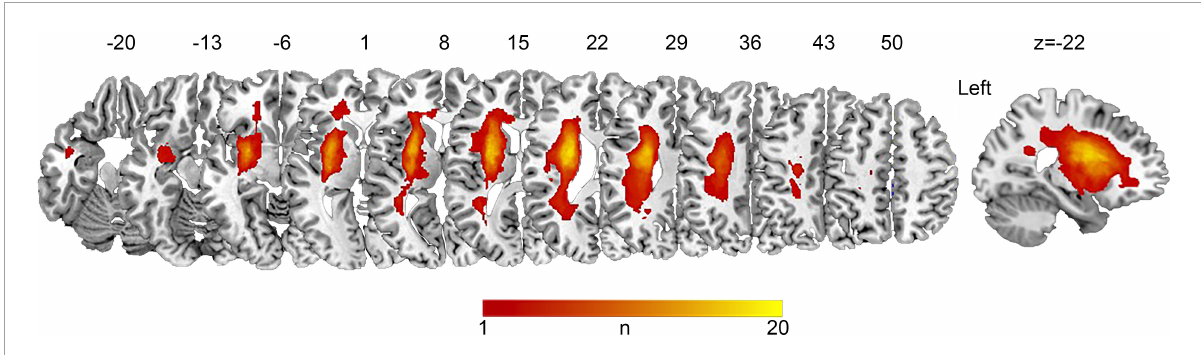
FIGURE1 Lesion overlap map of patients with chronic subcortical stroke. Lesions from 32 patients were normalized to the MNI space. The n -value denotes the number of patients with a lesion in each voxel (maximum 20 out of 32).